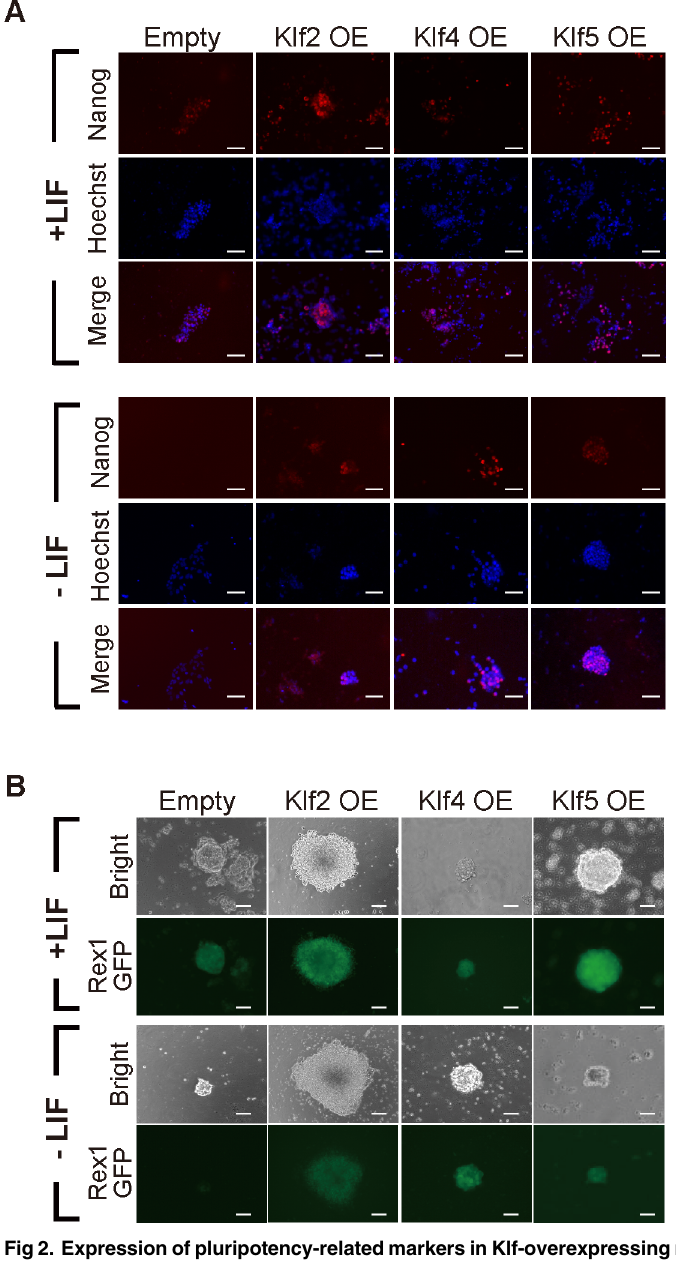
Fig 2. Expression of pluripotency-related markers in Klf-overexpressing mouse ES cells. (A) Immunostaining for Nanog in mouse ES cells overexpressing (OE) a Klf protein, cultured in the presence or absence of LIF. (B) Rex1-GFP expression in Klf-overexpressing ES cells grown in the presence or absence of LIF. Scale bar: 100 μ